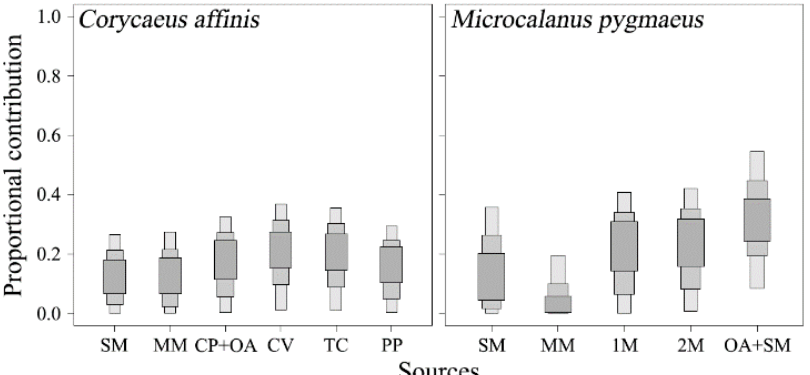
Figure 8. The stable isotope analysis in R mixing model results show the contributions of micro- particulate organic matter (POM) at the surface (0 m, 10 m), subsurface chlorophyll, 100 m, and 200 m depth layers, and small copepods to the diets of Corycaeus affinis in the south region of the subpolar front and Microcalanus pygmaeus in the north region using δ 13 C and δ 15 N values. The shaded boxes (dark to light) show 50%, 75%, and 95% credibility intervals for mean estimates. SM, surface layer micro-POM; MM, SCM micro-POM; 1M, 100 m depth layer micro-POM; CP, Clausocalanus pergens ; CV, Ctenocalanus vanus ; OA, Oithona atlantica ; SM, Scolecithricella minor ; TC, Triconia conifera .